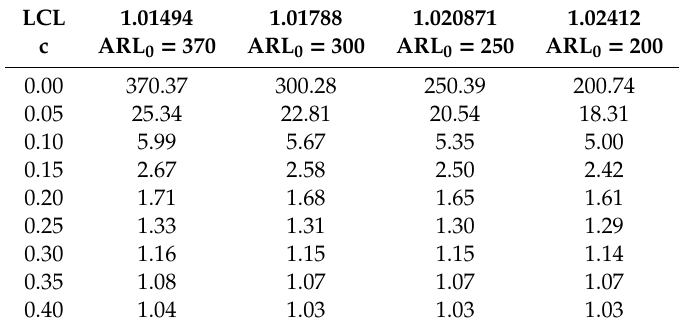
The ARLs for the proposed chart when n = 50, LND (0.45,1.50), USL = 74.7197, and LSL = 0.0329.